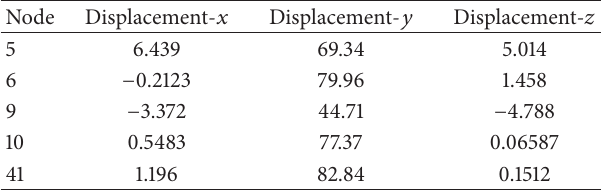
Table 6: The displacements (in m) at green nodes using the nonlinear FEM for the third experiment. The displacements at blue nodes are zero.